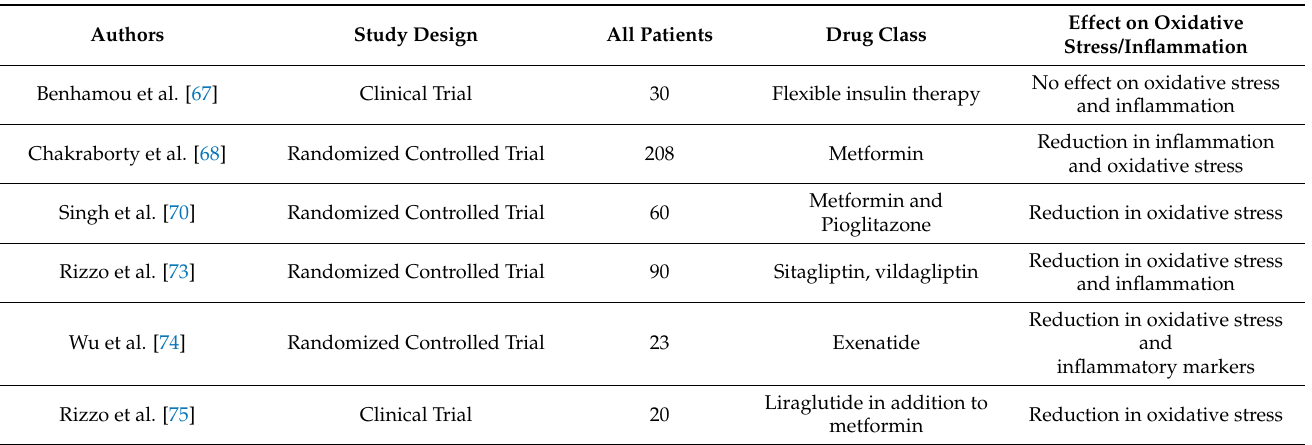
Table 4. Summary of the effects of particular hypoglycemic drugs on oxidative stress and inflamma- tion